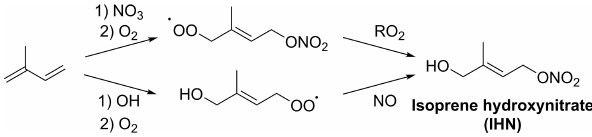
Figure 1. OH-initiated and NO 3 -initiated formation of IHN. The formation of 1,4-IHN is shown here; other IHN isomers, as well as additional reaction products, will also be formed.